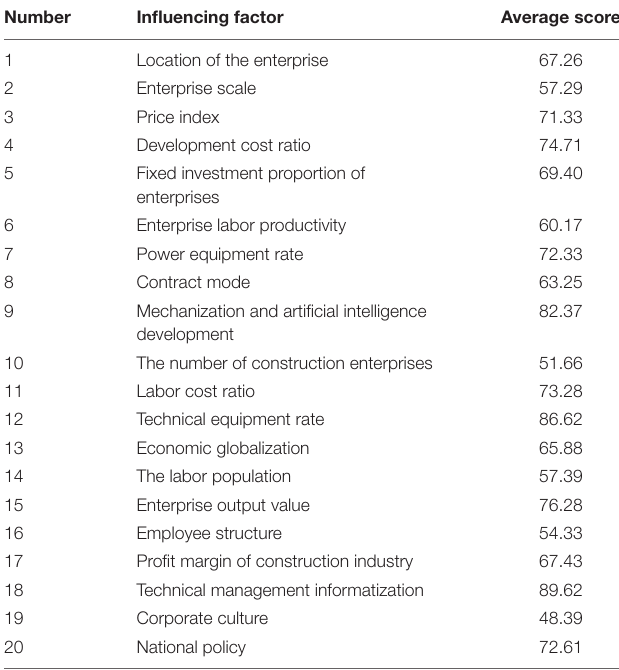
TABLE 6 | The enterprise technical management cost scored by the